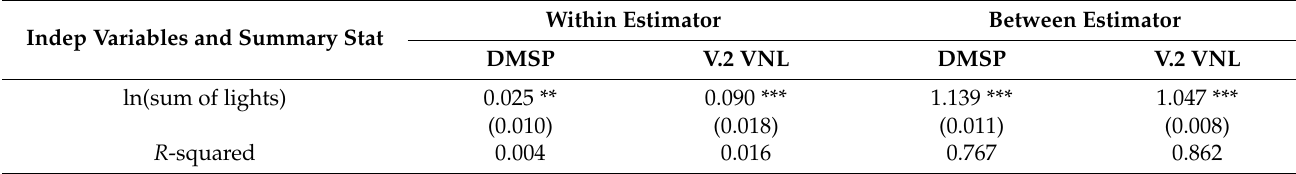
Table 6. Within and between estimators of GDP-lights elasticities: DMSP and V.2 VNL county-level results, 2014–18. Within Indep Variables and Summary Stat